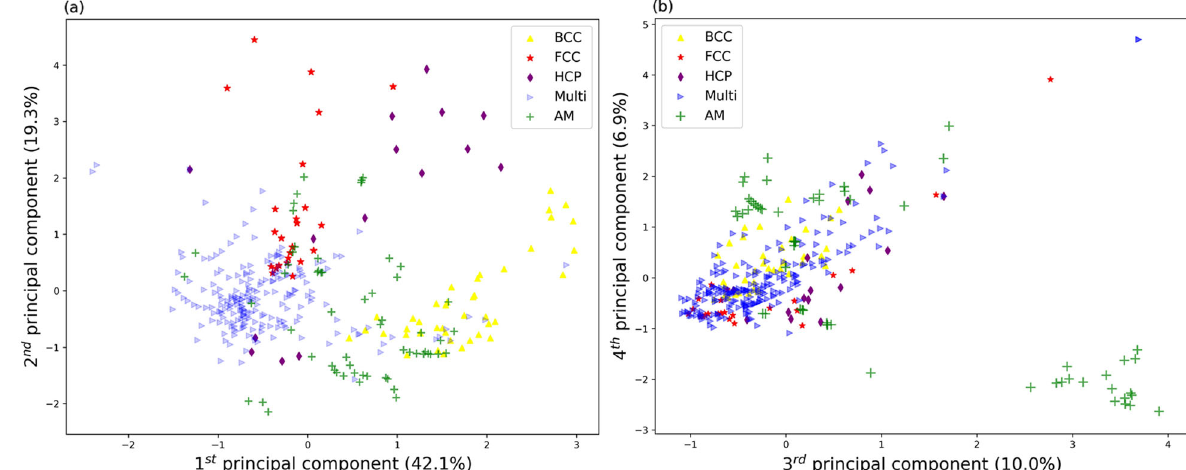
Fig. 7 The high-entropy alloys ’ fi rst four principal features generated by glass-forming ability model. Alloys are colored according to their phases. The percentage represents the ratio of the variance on the principal axis